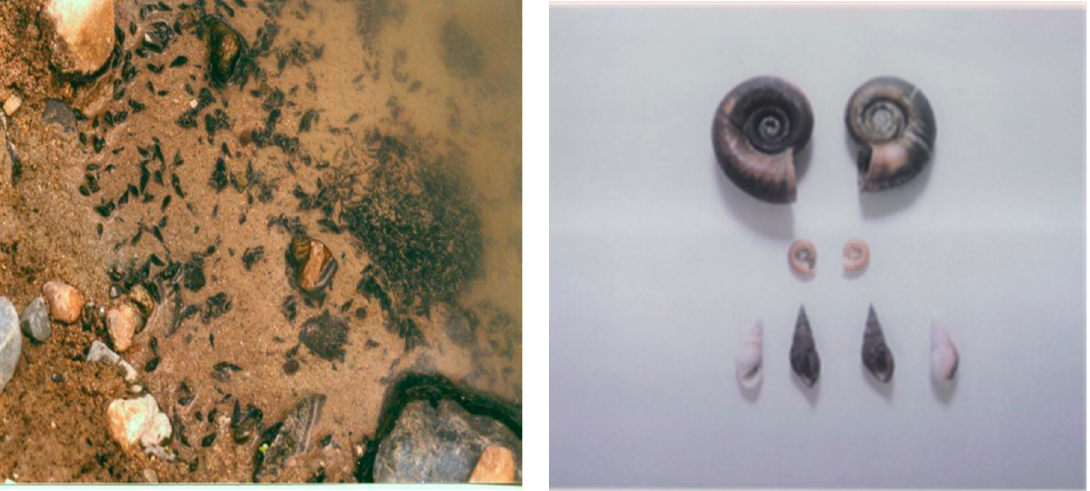
Figure 5. The competitive Thiara granifera snail in the wild ( left ) and a collection of shells ( right ), including Marisa cornuarietis (top), Biomphalaria glabrata (middle), and Thiara granifera